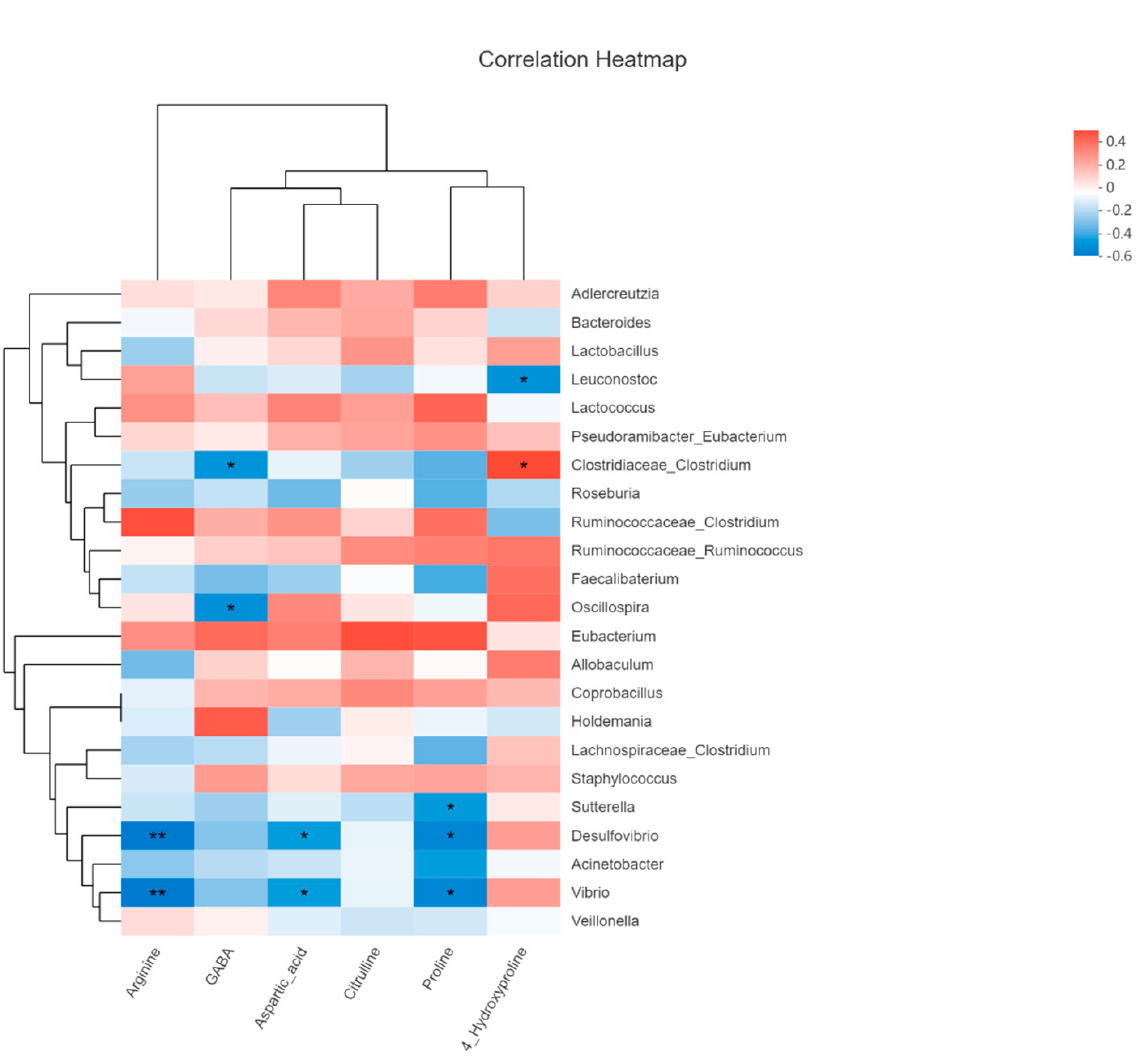
Figure 7. Heatmap of Spearman’s correlation between differential taxa and metabolites of rat, * p < 0.05, ** p < 0.01.